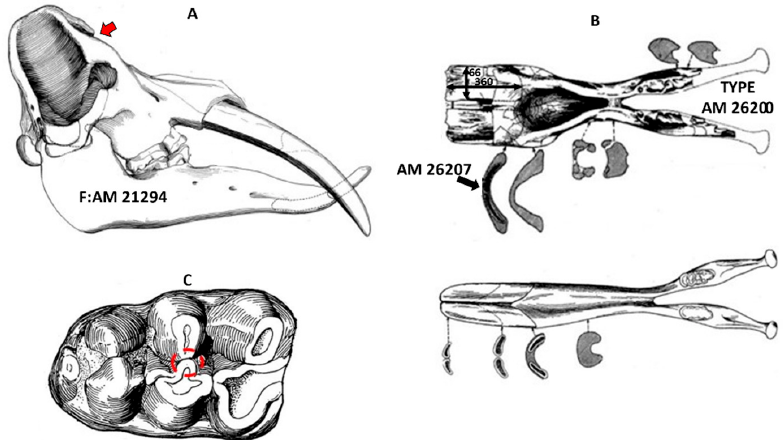
Figure 1. Gomphothere skull and tooth morphology. ( A ). Gomphotherium productum (modified